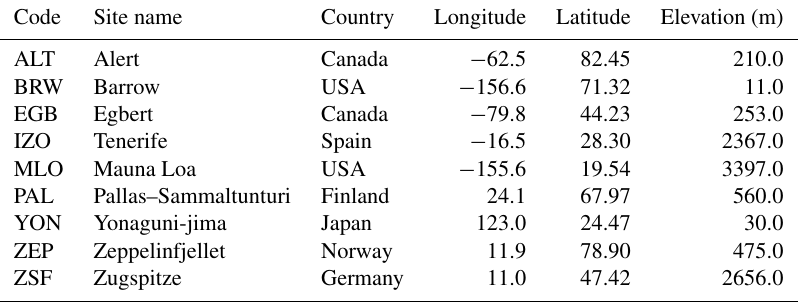
Table 1. Locations of selected stations measuring atmospheric CO 2 concentrations used for comparison in the forward